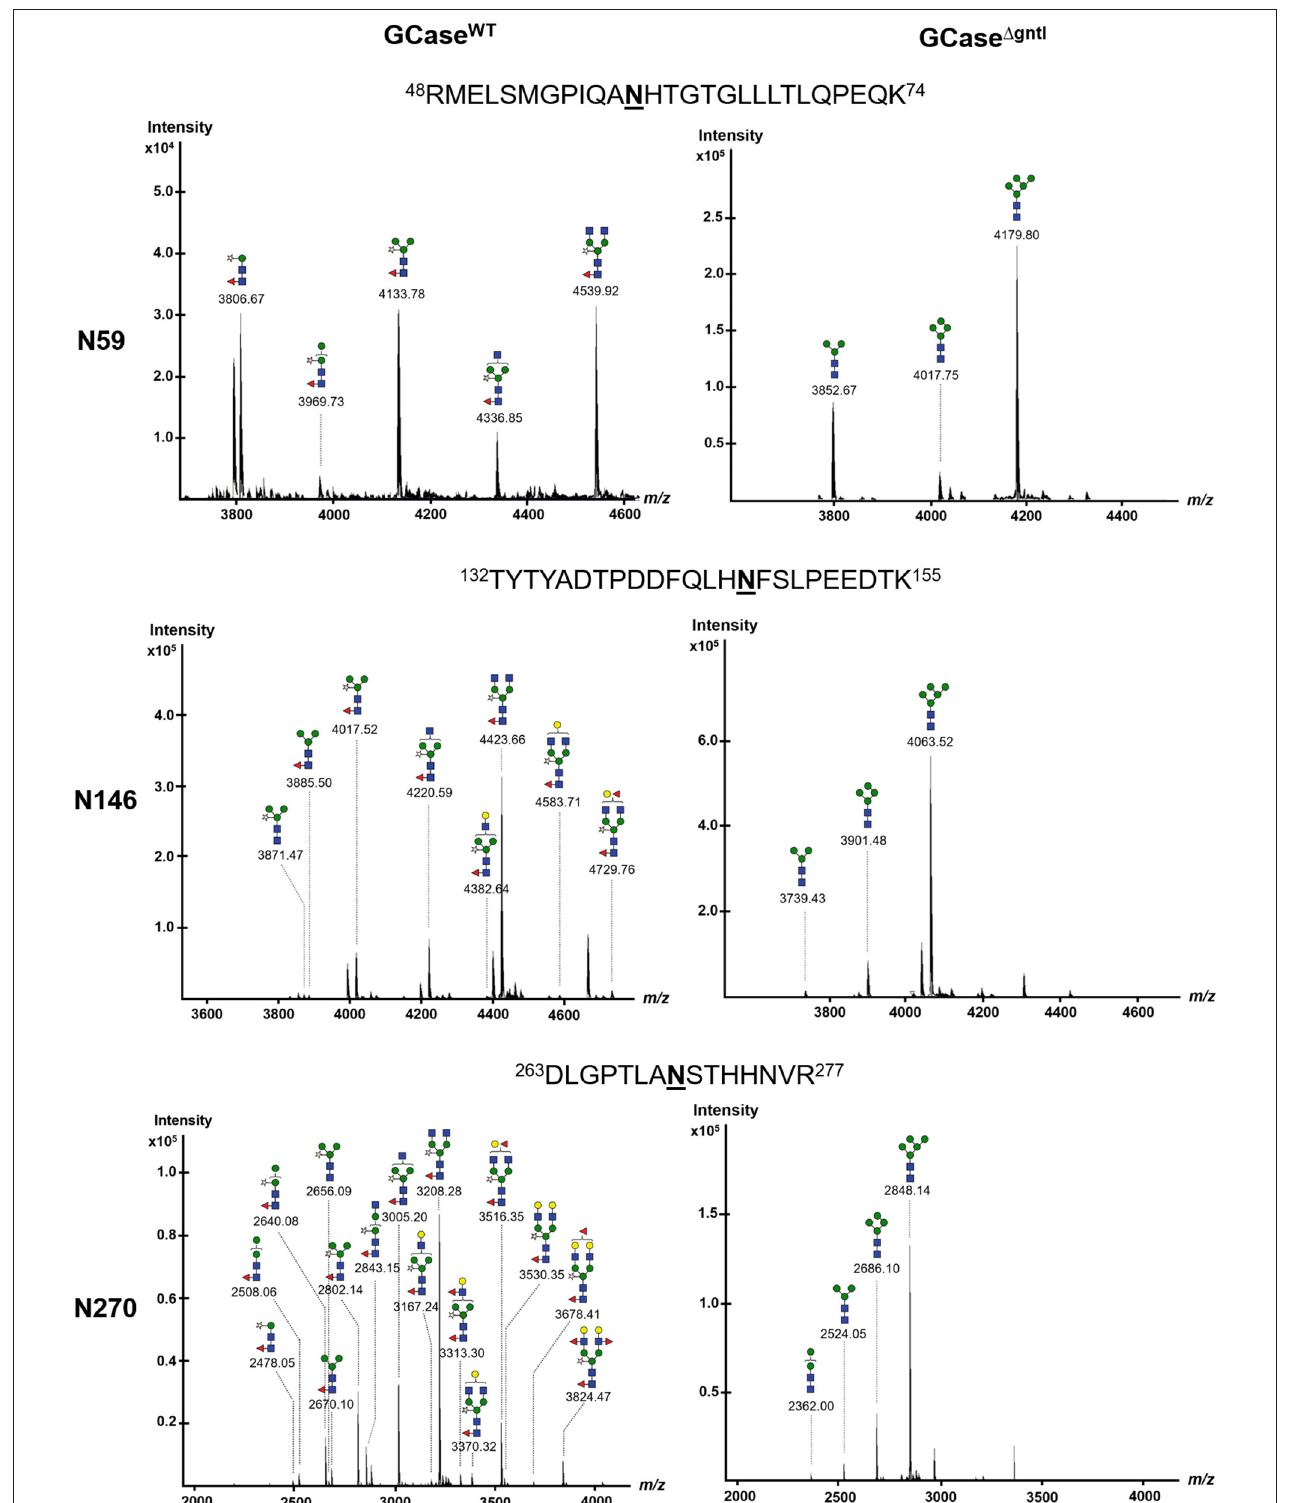
FIGURE 4 | Nano LC–MS spectra of glycopeptides derived from purified GCase produced in wild-type (WT) and 1 gntI-infiltrated leaves. Glycan structures of glycopeptides are shown at different N -glycosylation sites (N59, N146, and N270).